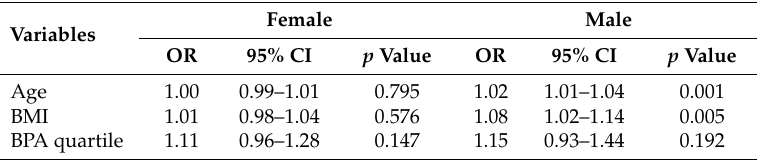
Table 4. Logistic regression analyses: predictors for TgAb positive by